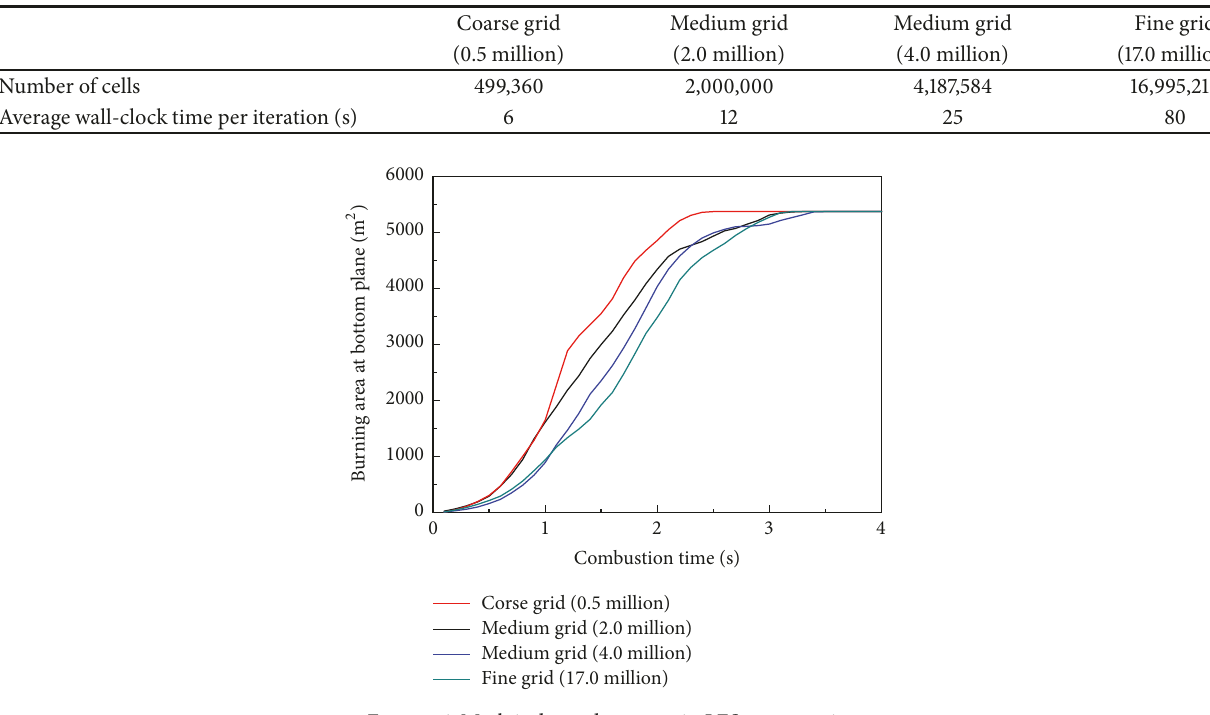
Figure 6: Mesh independence test in LES computation.